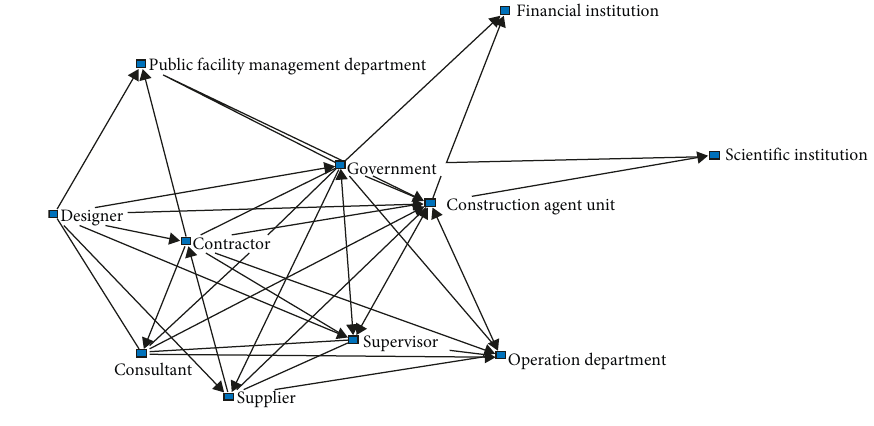
Figure 1: Social network of stakeholders. Table 3: Centrality and individual network density of